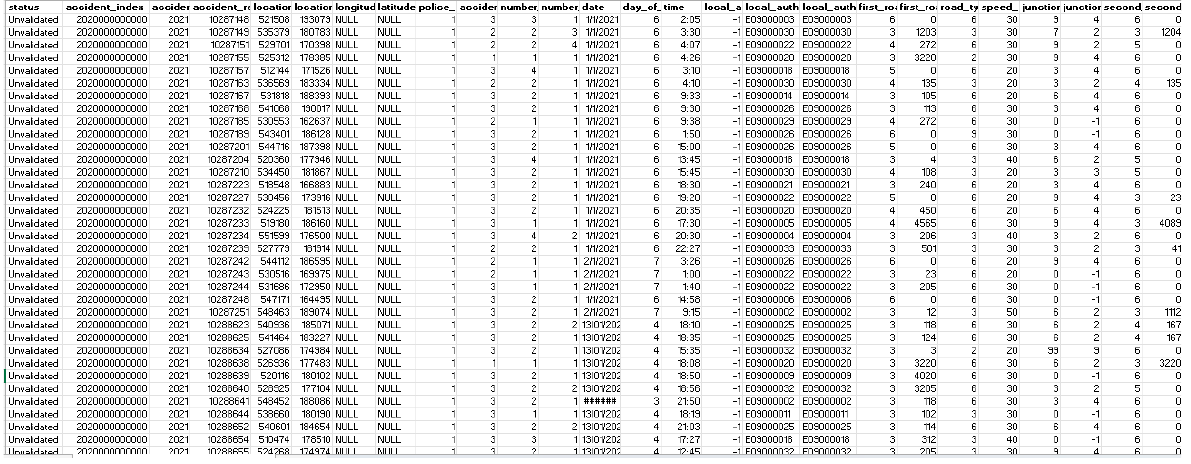
Figure 5. Dataset description with sample values used inside the research. Table 3. Simulation parameters. Table 3. Simulation